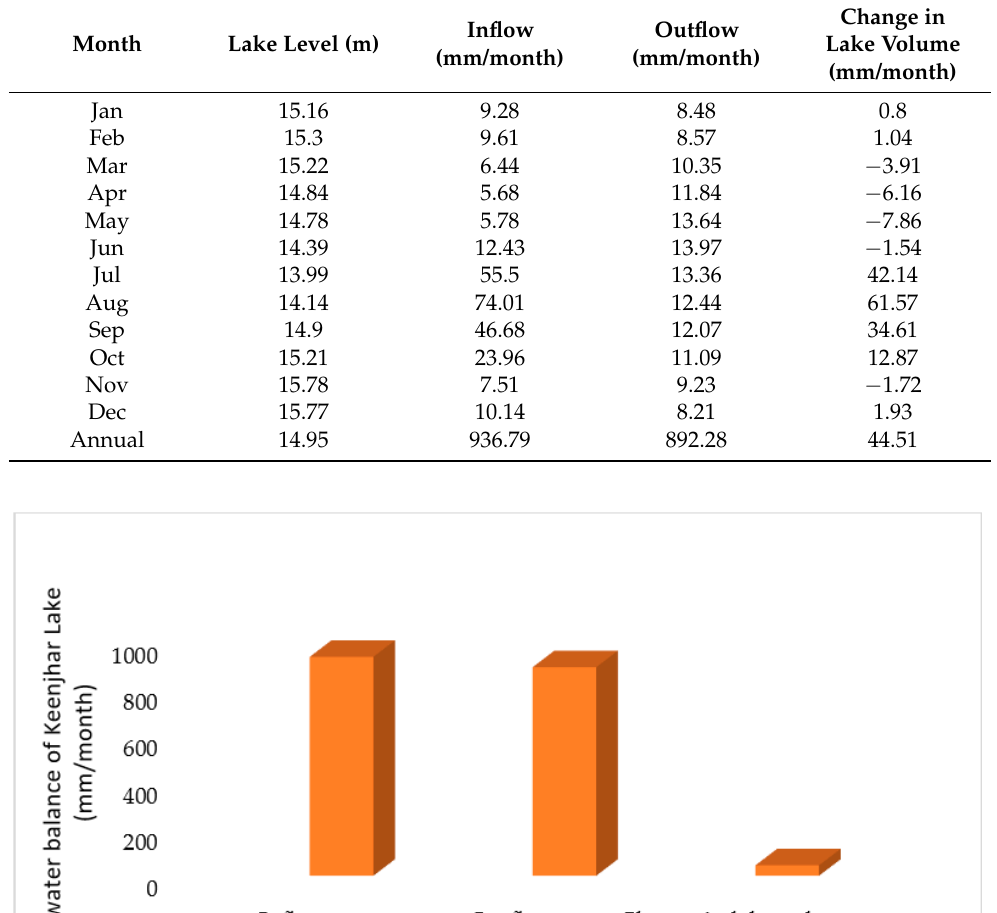
Table 3. Mean monthly water balance of Keenjhar Lake (2000–2016).